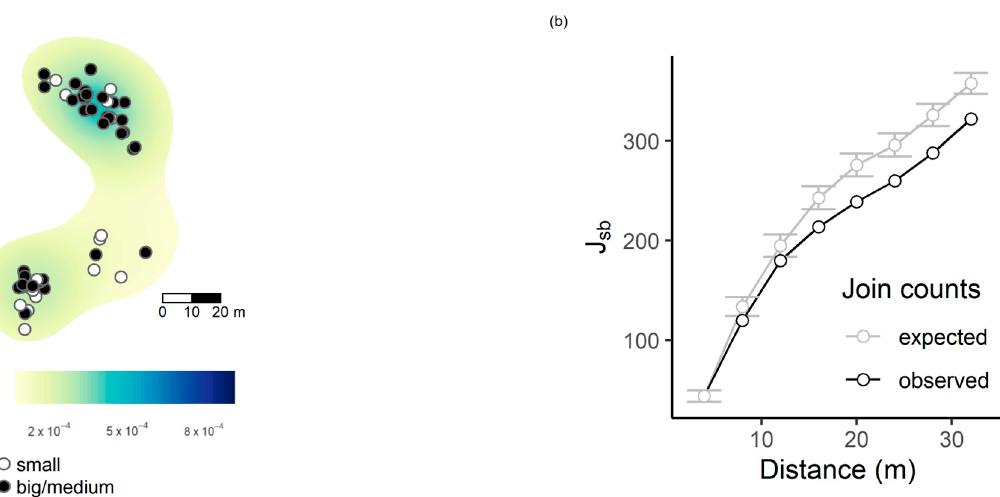
Figure 4. Kernel-smoothed density of large/medium Myrmica colonies at the end of larval development, in Kosy ń ( a ). Panel ( b ) shows the significance of the segregation (join count statistics, J sb ) between big-medium nests (grouped together) and small nests. In case of significant segregation, observed values must be smaller than expected.